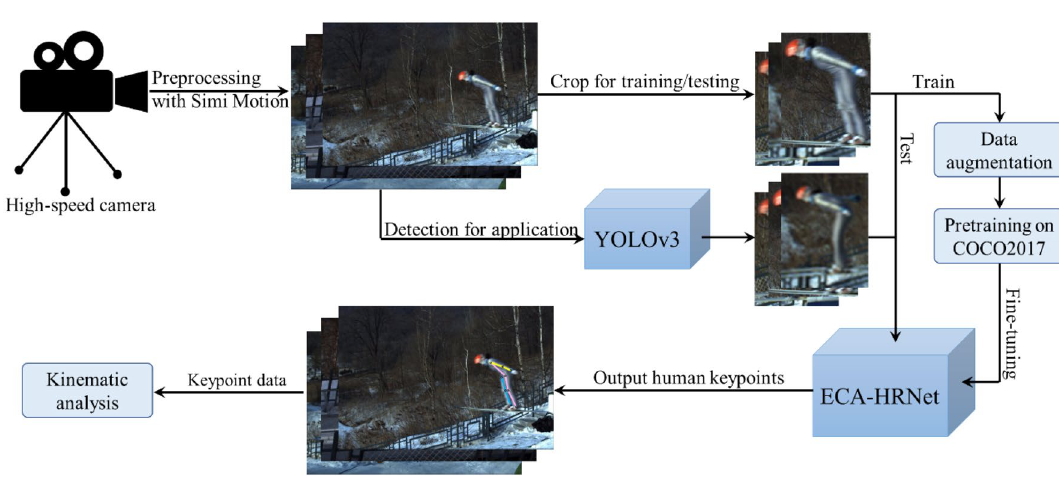
Figure 7. Transfer learning strategy.